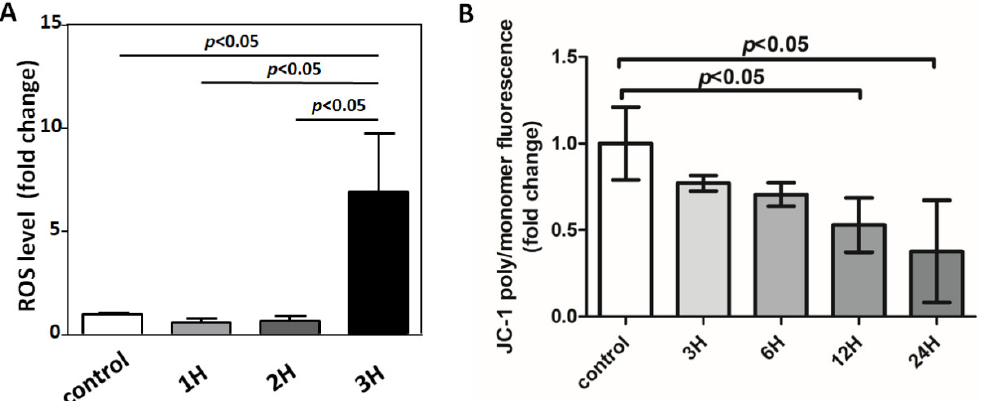
Figure 7. IS induced mitochondrial dysfunction and ROS production . ( A ) Cells treated with IS for various durations (1 h, 2 h, and 3h), and ROS level determined by staining with H 2 DCFDA fluorescent dye, followed by flow cytometry analysis. The ROS increases markedly at 3 h after IS treatment. ( B ) IS-treated astrocytes induce loss of mitochondrial membrane potential as measured by JC-1 and flow cytometry at 12 and 24 h. Data represent mean ± SD of a representative experiment.